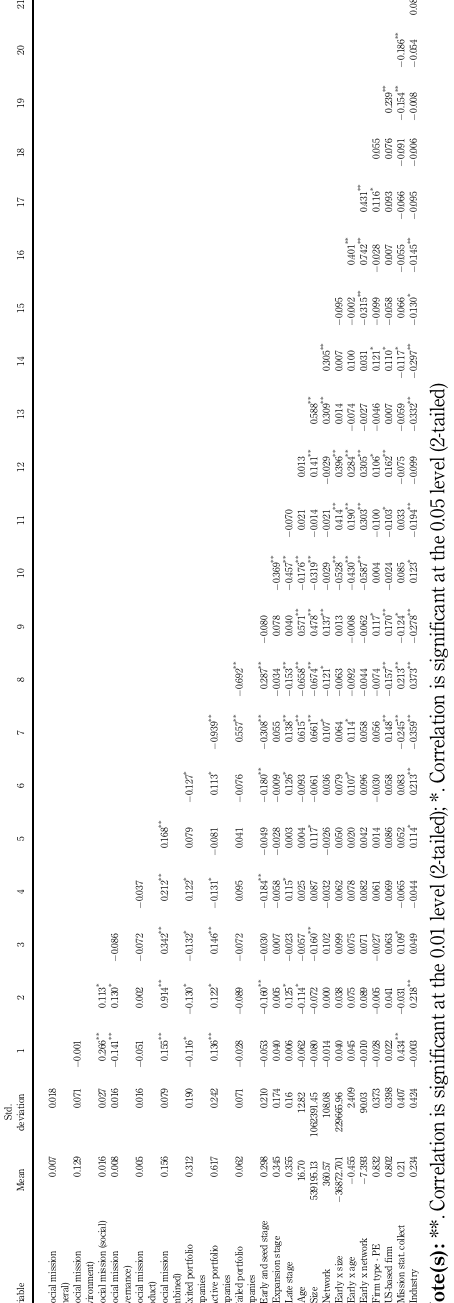
Table 2. Means, standard deviations and